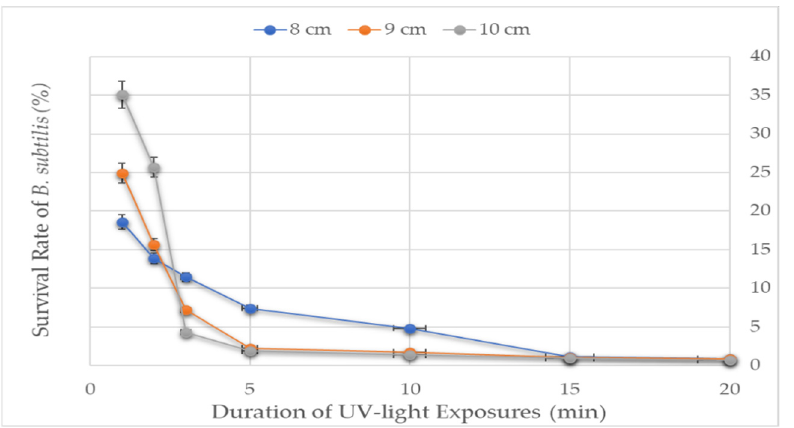
Figure 7. The survival rate of B. subtilis to UV-light treatment. UV-light tolerance of the B. subtilis was measured at three distances between the sample and the UV-lamp for seven varying exposure times.